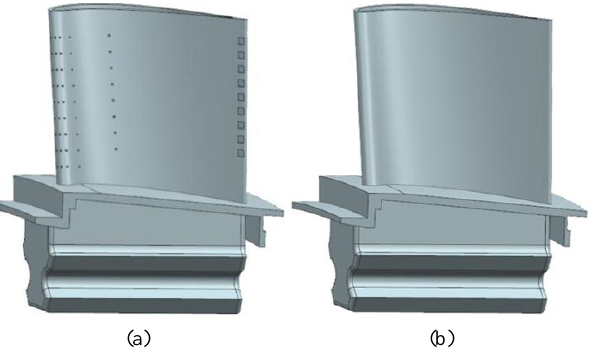
Figure 10. Detail features of blade geometric model suppression: ( a ) Before suppression, ( b ) Af- ter suppression.